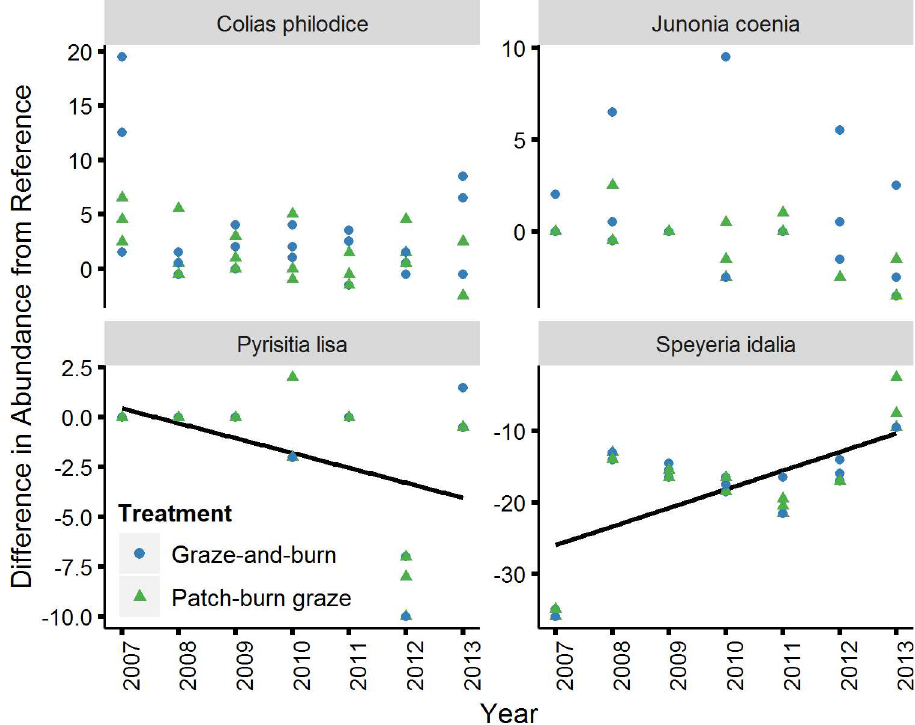
Fig 2. Difference in abundance from referencesite of four butterfly species. Linear trends in species abundance at degradedsites were tested using the differencebetween the abundanceat each degradedsite and the averageabundanceof the two reference sites. All species presented in this figure showed a significant relationship with year below α = 0.05. Lines depict relationships that were significant when considering Bonferroni correction (p < 0.004). Note : scale on the Y axis is different for each species